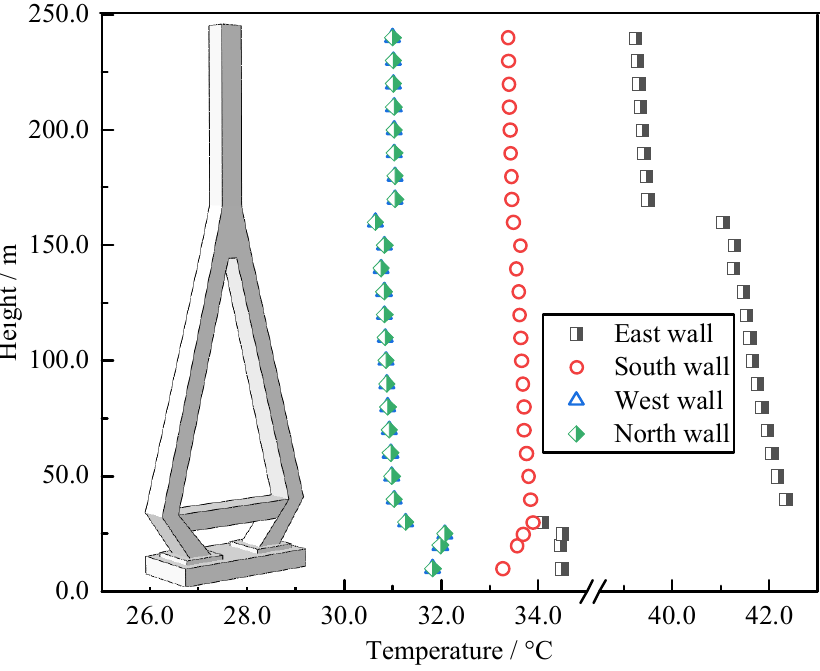
Figure 20. The temperature change of the bridge tower surface with height at 10:00 a.m.